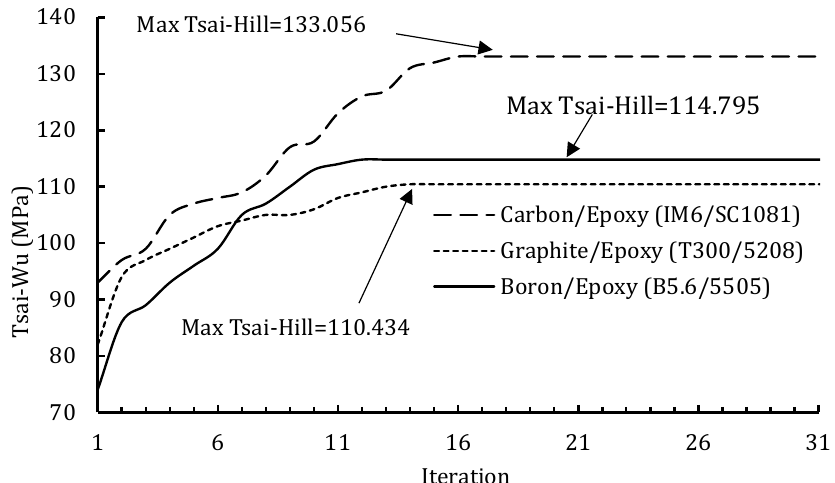
Figure 7. Convergence diagram for optimum values according to the maximum values of Tsai-Hill (MPa) Fig. 8 Convergence diagram for optimum values with maximum Tsai-Hill (MPa). criterion. Carbon/Epoxy (IM6/SC1081) ( w = 0.05, θ 1 = 40.6 ◦ , θ 2 = 90 ◦ , θ 3 = 135 ◦ ), Graphite/Epoxy (T300/5208) ( w = 0.052, θ 1 = 86.7 ◦ , θ 2 = 88.4 ◦ , θ 3 = 39.4 ◦ ), and Boron/Epoxy (B5.6/5505) ( w = 0.056, θ 1 = 90 ◦ , θ 2 = 90 ◦ , θ 3 = 135 ◦ ).